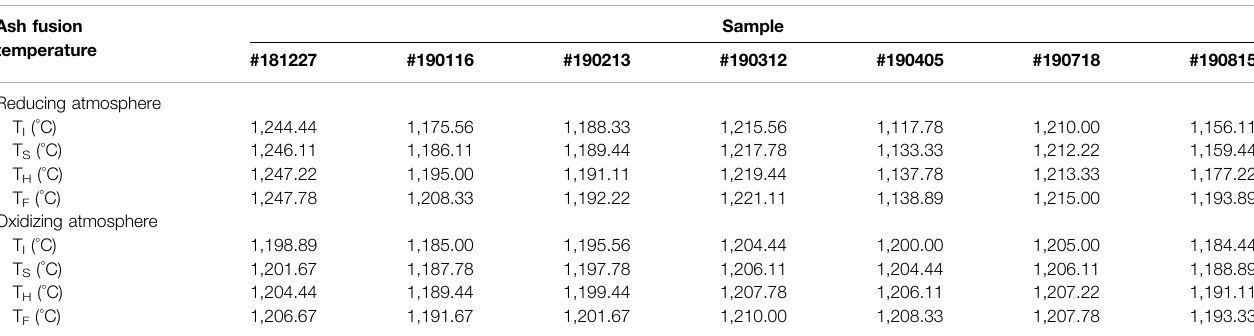
TABLE 6 | Ash fusion temperature of selected CCDWDF